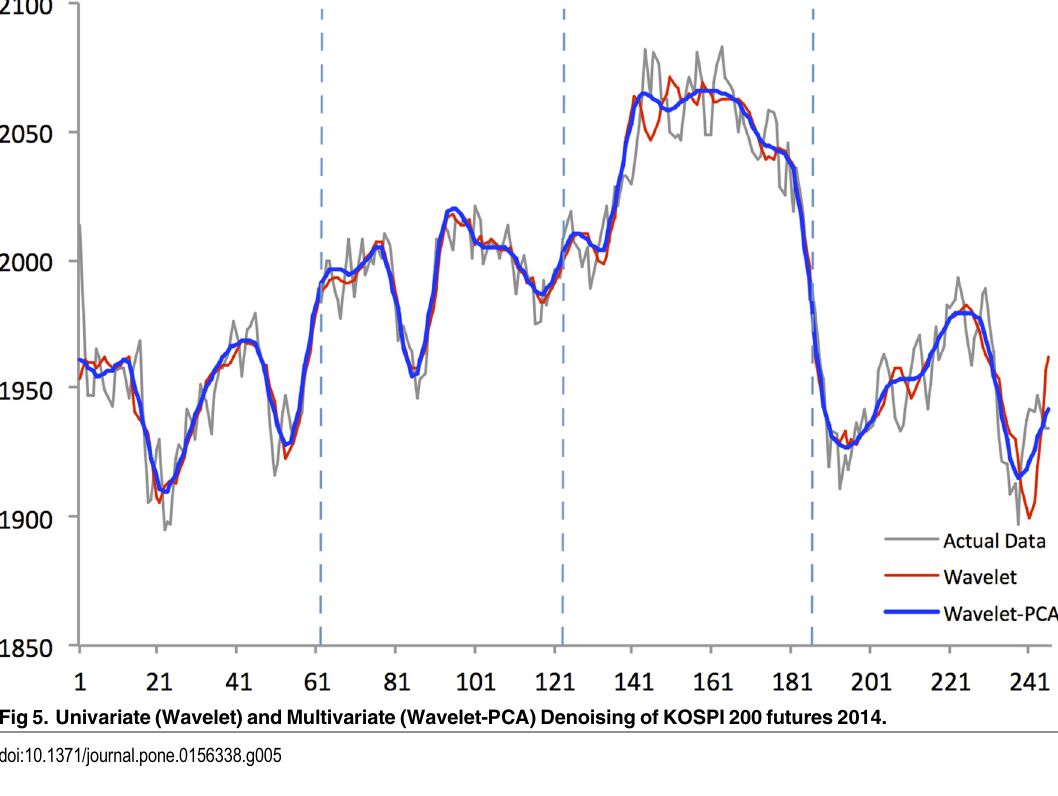
Fig 5. Univariate (Wavelet) and Multivariate (Wavelet-PCA) Denoising of KOSPI 200 futures 2014.